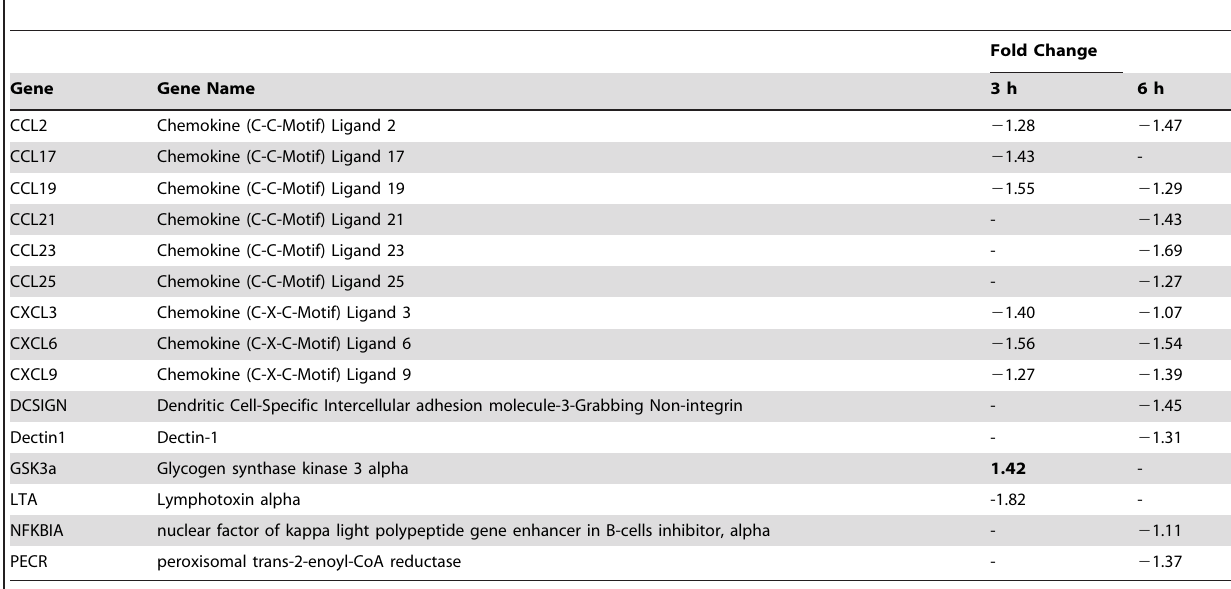
Table 1. Gene Expression in A549 epithelial cell layer induced by addition of A. fumigatus conidia.